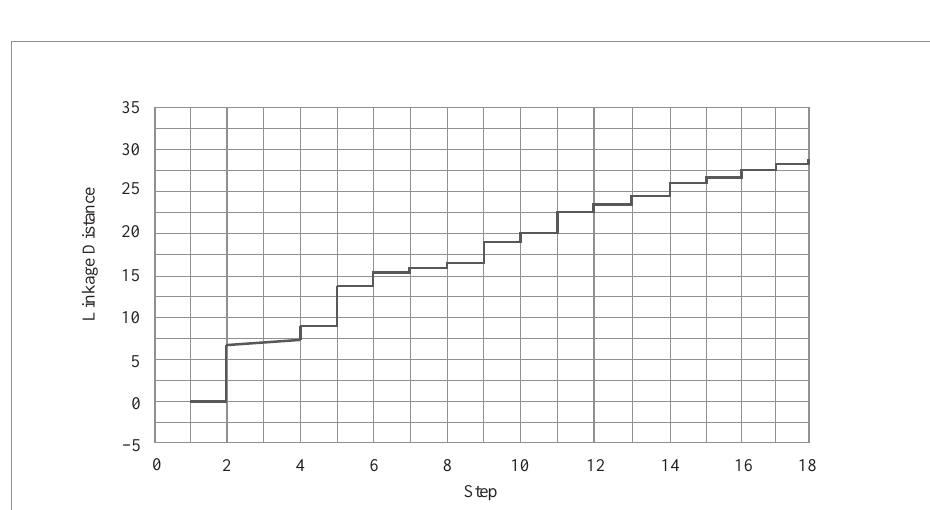
Fig. 10. Plot of linkage distances across